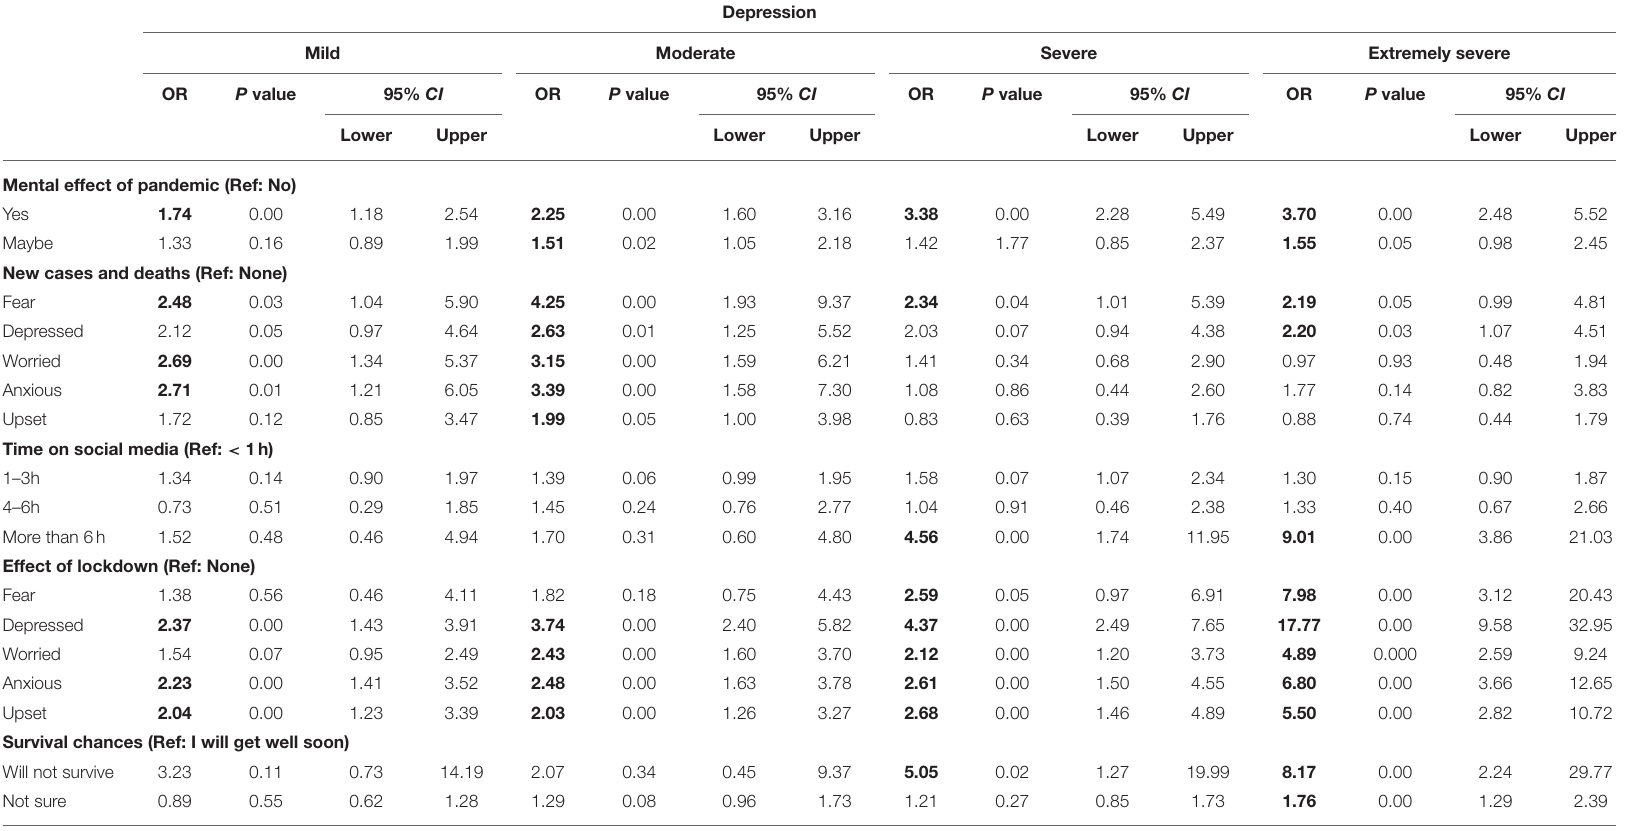
TABLE 4A | Association of level of severity of depression with the personal feeling variable identified with multinomial logistic regression. Depression Mild Moderate Severe Extremely